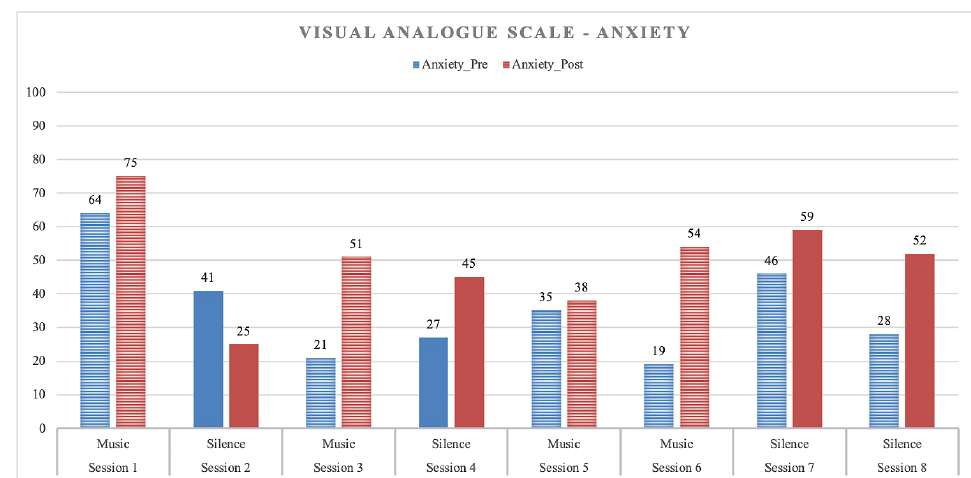
FFigigururee 44 Pre- and post-treatment scores for anxiety completed before and after each treatment in all sessions. Solid colours represent VA-Silence sessions. Visual Analogue Scales range from 0 (very anxious) to 100 (no anxiety). Point increase (+) relates to less anxiety.